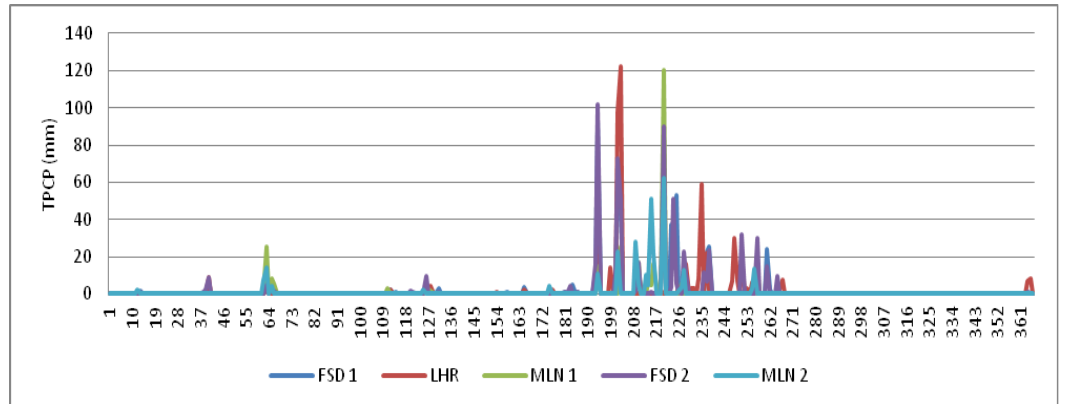
Figure 11. Pakistan Meteorology TPCP at (~1 km) spatial data (near-real-time daily rainfall accumu- lative data in mm) are accumulated for one month over five stations and show heavy rainfall from JD-185 to JD-232. Table 2. The linear correlation coefficients between VTCI imagery from D-009 to D-361 during 2010 and cumulative precipitation anomalies for the 16-day to 12-month periods during 2009 – 2010.